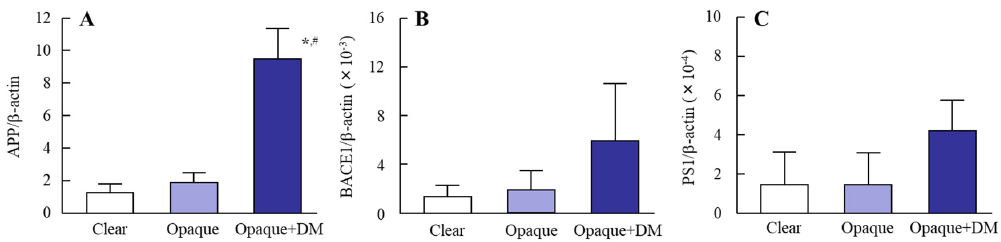
Figure 3. Changes in APP ( A ), BACE1 ( B ), and PS1 ( C ) mRNAs in lens epithelium of diabetic patients. Patient characteristics are shown in Table 1 (PCR method group). Open columns, transparent lens epithelium; closed columns, opaque lens epithelium. Clear, transparent lens epithelium; opaque, opaque lens epithelium; opaque + DM, opaque lens epithelium with type 2 DM. n = 3–15. * p < 0.05, vs. clear for each group. # p < 0.05, vs. opaque for each group.